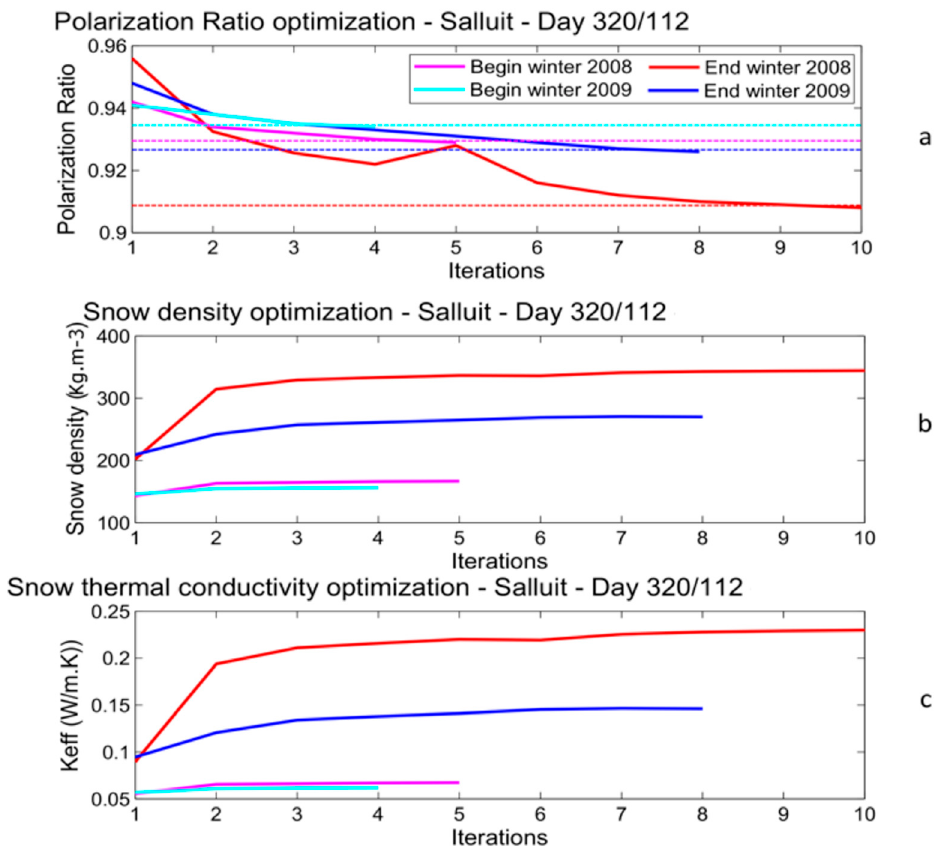
Figure 7. Convergence of the polarization ratio at 11 GHz ( a ), the derived snow density variation ( b ), and the derived simulated snow thermal conductivity ( c ) at the Salluit site for 2008 and 2009 for winter onset (day 320) and the end of winter (day 112).